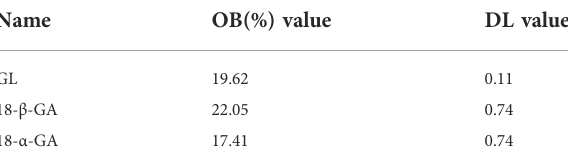
TABLE 1 OB value and DL value of major ingredients-GA and GL in